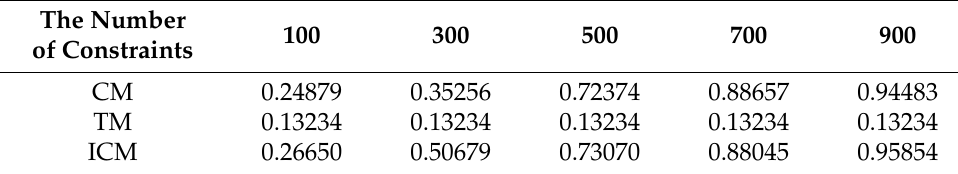
Table 3. Comparison of Adjusted Rand Index on dataset Balance.